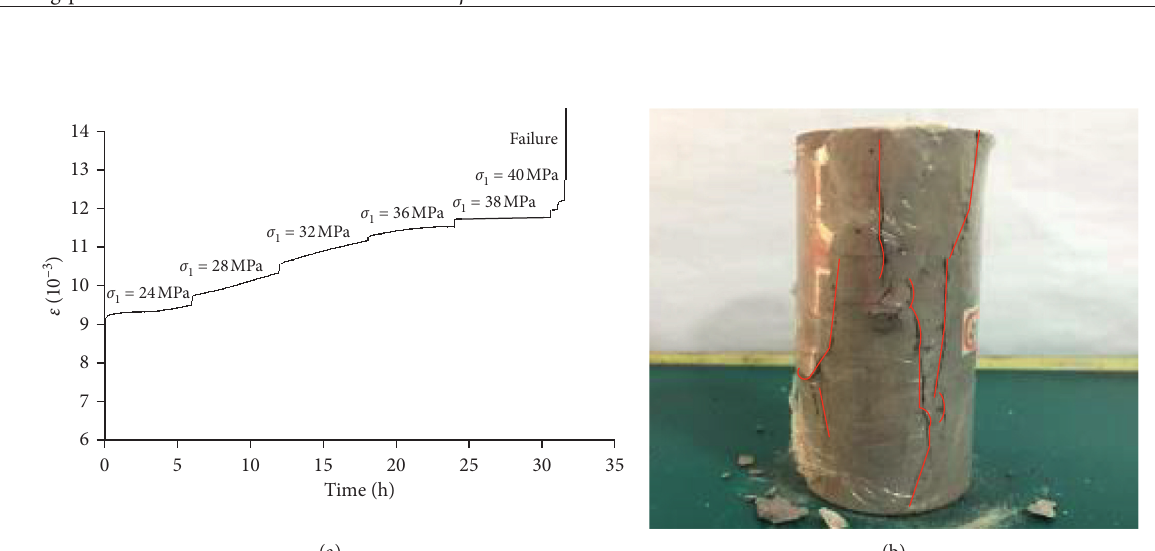
Figure 7: Uniaxial rheological test results of mudstone. (a) Strain-time curve. (b) Failure form of mudstone.